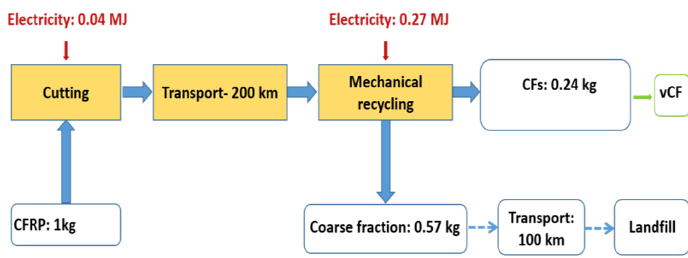
Figure 13. Flow diagram of mechanical recycling with landfill.